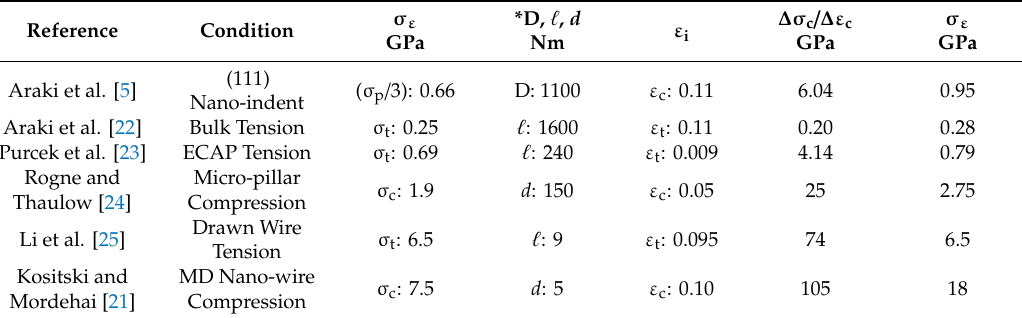
Table 2. Comparison of α -iron nano-indentation and other material property